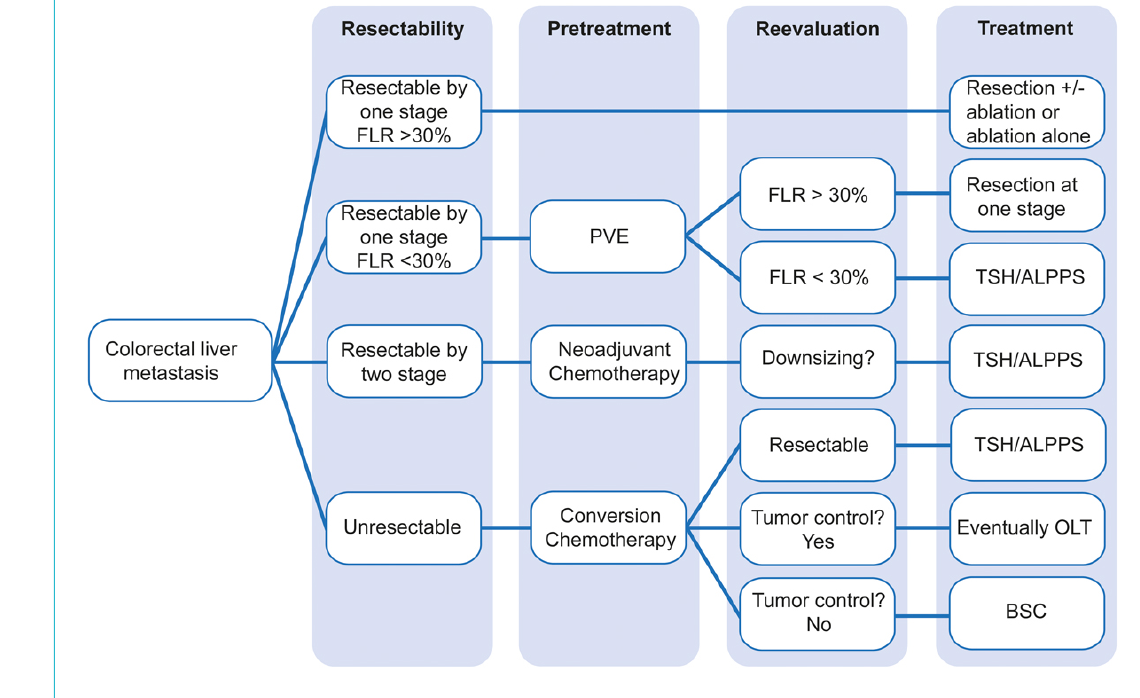
Figure 1: Flow chart of the treatment algorithm for colorectal metastases at the Swiss HPB Centre, Zurich, Switzerland.ALPPS = associating liver partition and portal vein ligation for staged hepatectomy; TSH = classical two-stage hepatectomy; BSC = best supportive care; FLR = fu- ture liver remnant; OLT = orthotopic liver transplantation; PVE = portal vein